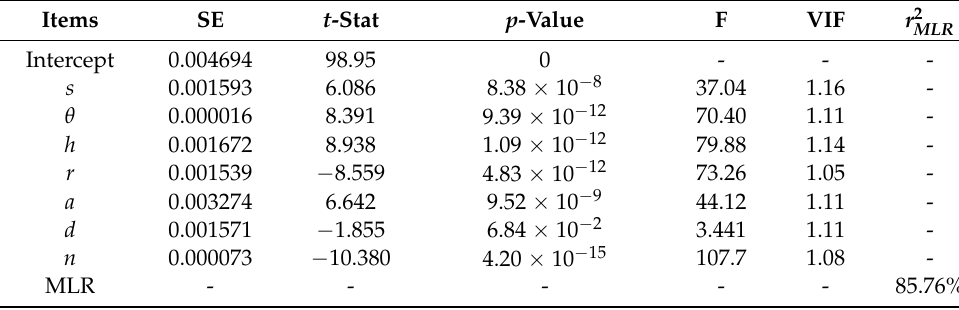
Table 4. Regression analysis of independent variables for the MLR model.